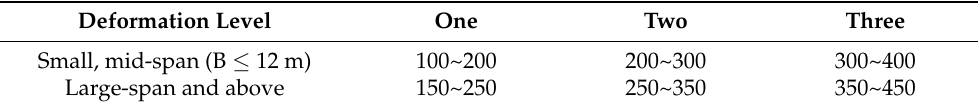
Table 3. Reference reserved deformation for extruded surrounding rock tunnel (unit: